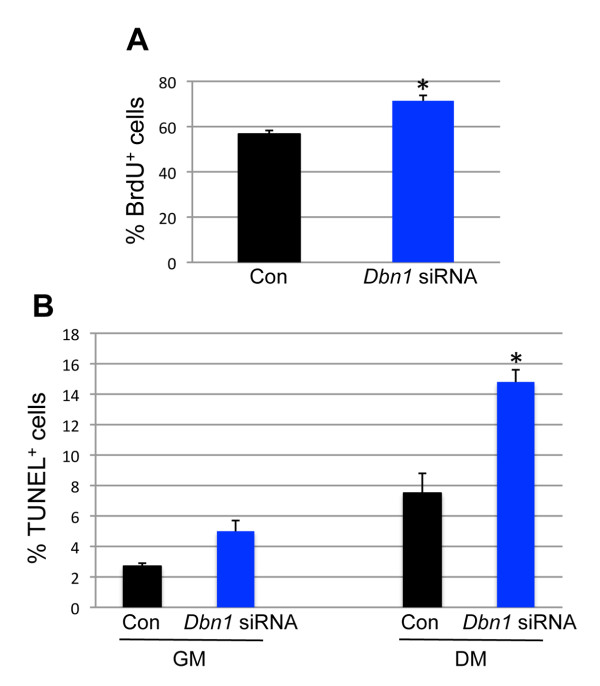
Cell proliferation and apoptosis in primary myoblasts depleted of drebrin. (A) Primary myoblatsts were transfected with control or Dbn1-specific siRNA. Cells were cultured for 36 hours in growth medium (GM), then exposed to bromodeoxyuridine (BrdU) for 2 hours and finally fixed and stained with antibody against BrdU. Values shown are means ± SD of triplicate determinations. (B) Primary myoblasts were transfected with control (Con) or Dbn1-specific siRNA. Cells were cultured in GM for 36 hours or in differentiation medium for 48 hours. Values shown are means ± SD of triplicate determinations. *P < 0.01 by Student's t-test.